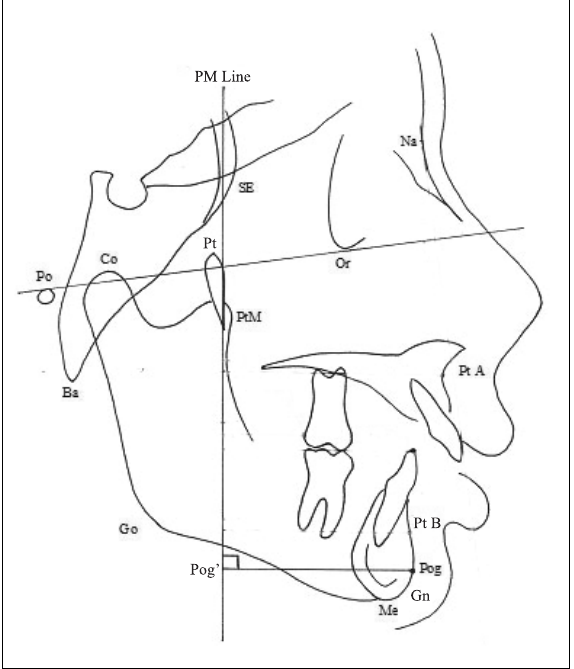
Figure 1. Cephalometric landmarks used in this study.